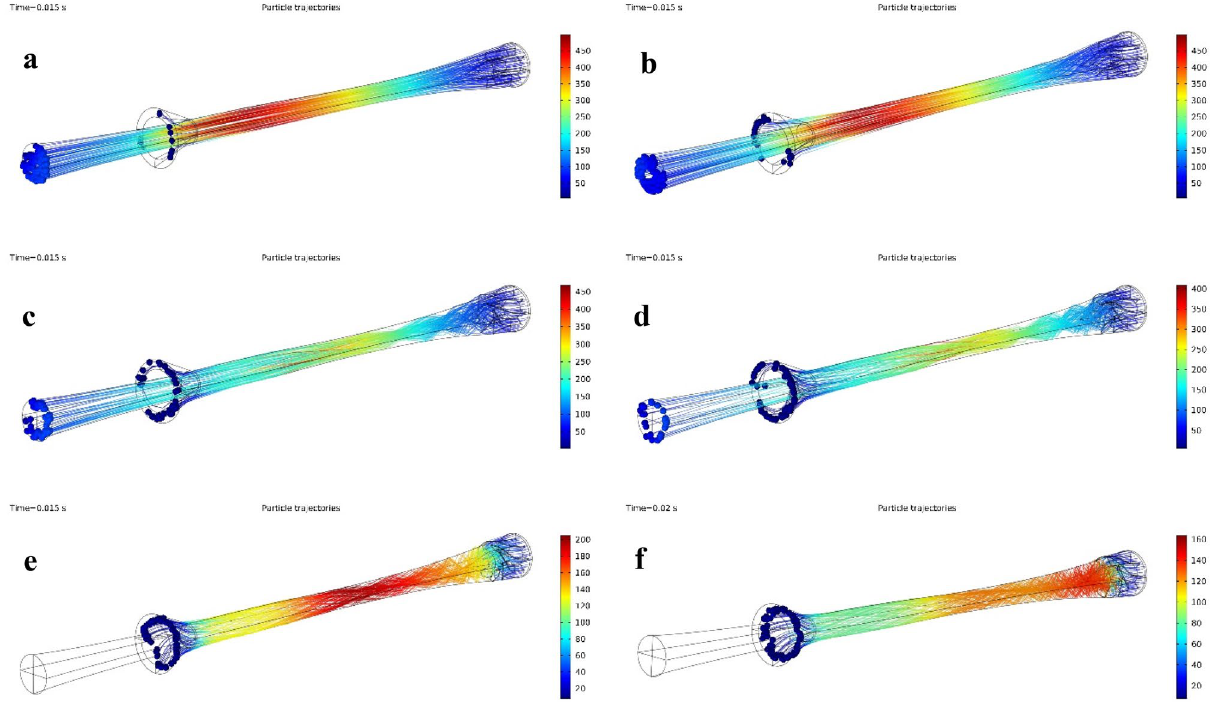
Figure 10. Droplet trajectories and velocity profile for various swirl angles ( a ) 10°, ( b ) 20°, ( c ) 30°, ( d ) 40°, ( e ) 50°, ( f )